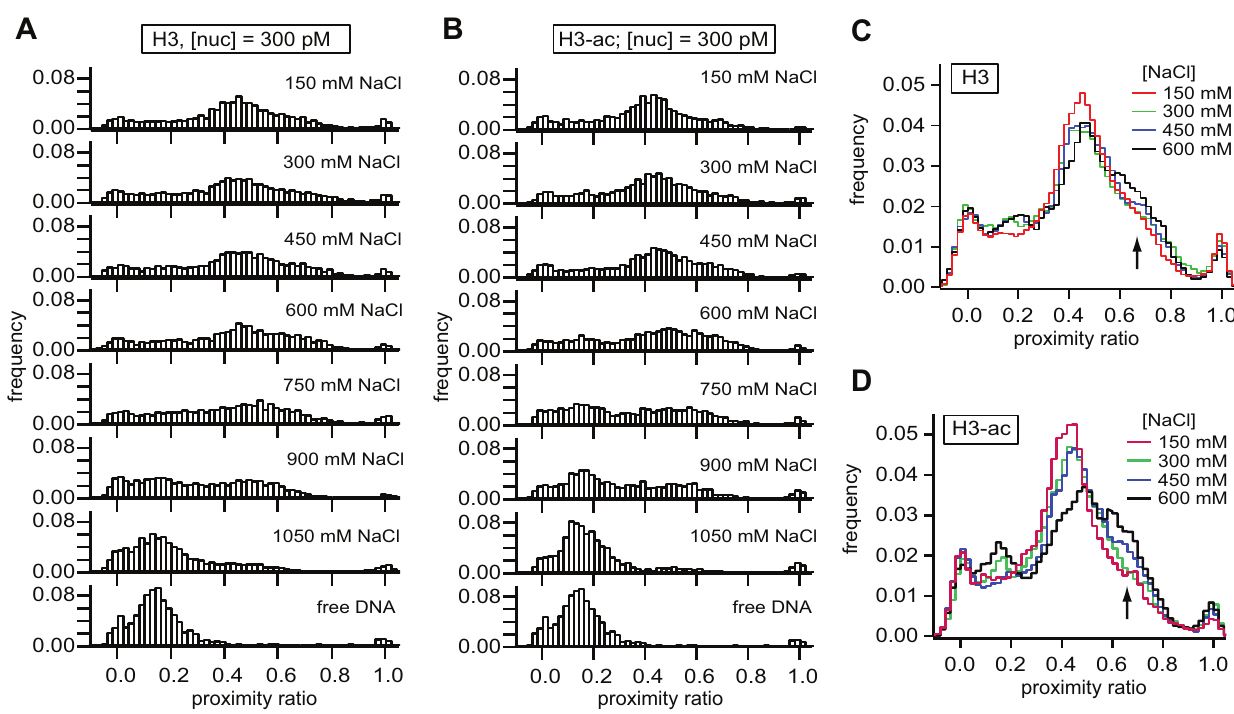
Figure 5. smFRET analysis reveals a conformational transition prior to nucleosome unwrapping. A,B ) smFRET histograms of non- acetylated and H3-acetylated nucleosomes at various salt concentrations and 300 pM total nucleosome concentration. Above 300 mM NaCl, a fraction of H3-acetylated nucleosomes populates a second conformation with slightly increased proximity ratio compared to non-acetylated nucleosomes, which appear to retain their initial structure. C, D ) Overlay of histograms for salt concentrations between 150 mM and 600 mM NaCl for non-acetylated (C) and H3-acetylated nucleosomes (D). Data were smoothed once to better visualize the gradual transition of nucleosomes into the high FRET